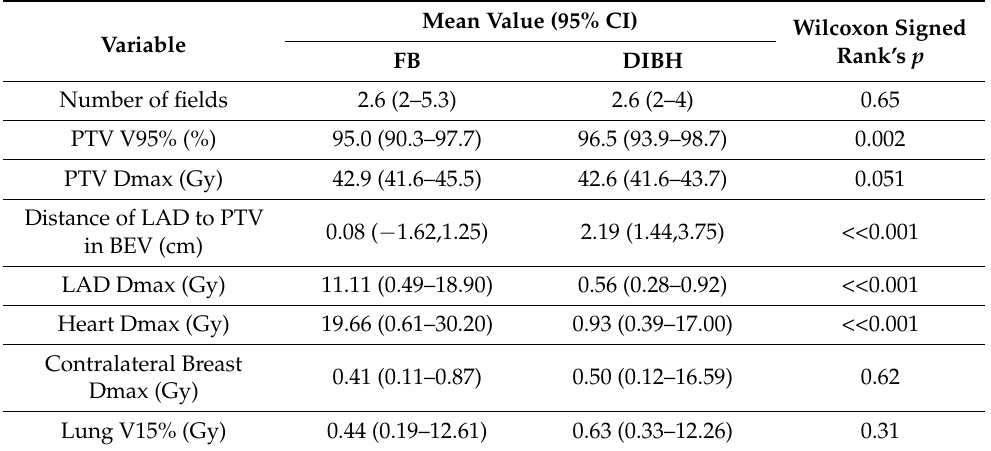
Table 2. Results of comparison treatment plans in FB and DIBH